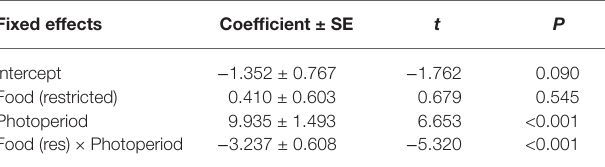
TABLE 3 | Estimates of the fixed effects from the mixed-effects generalized linear models (the best model chosen after multi-model selection, see Table 2 ) used to assess the determinant factors on thermal differential ( T DIFF